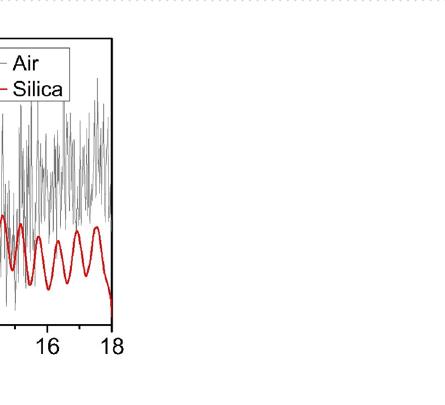
Figure 5. Frequency response of a horn ( a ) and a spiral ( b ) antennas.